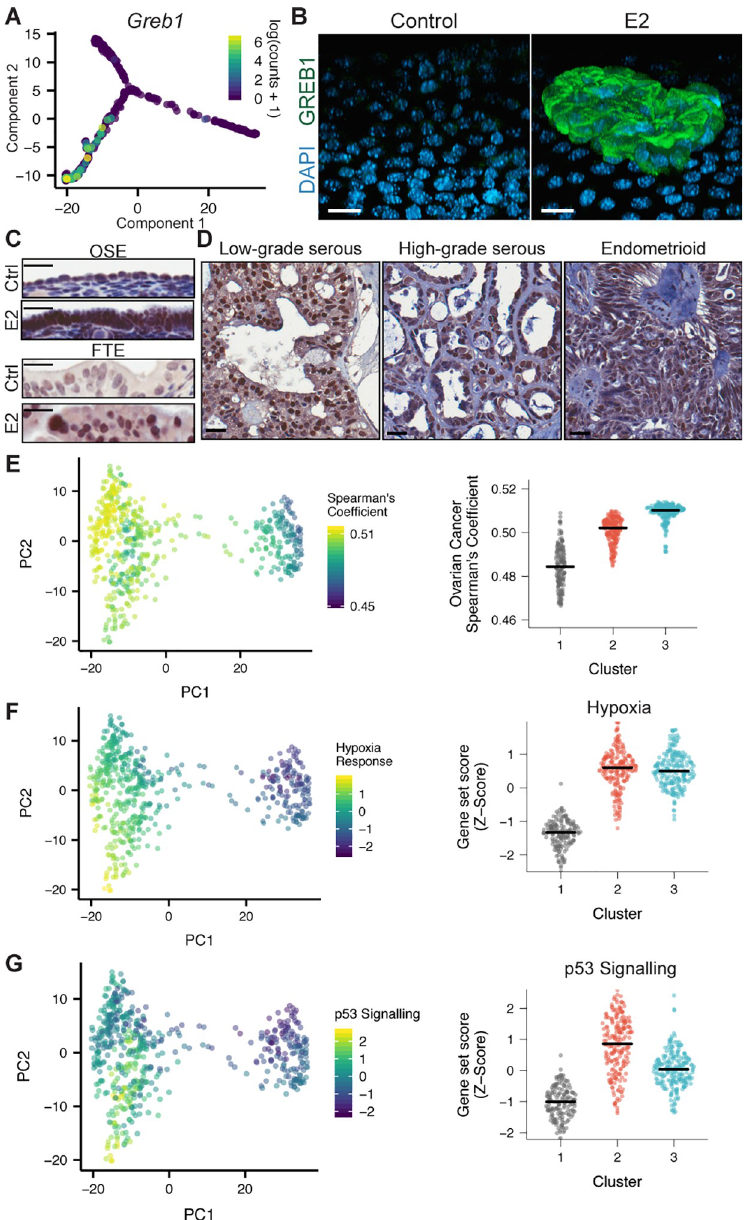
Fig 7. Prolonged E2 exposure leads to up-regulation of GREB1 in stratified OSE cells. (A) Trajectory of OSE cells, coloured by the logged Greb1 counts. (B) Control and E2-treated OSE cells stained for GREB1 by IF. Scale-bar = 15 μ m. Representative images display z-stack maximal intensity projections of GREB1 and DAPI channels rotated 45˚ along Y-axis to best display image in XYZ dimension. n = 6–8. (C) IHC staining of GREB1 in the OSE and FTE from placebo and E2-treated mice (OSE: n = 4; FTE: n = 3) and three subtypes of human ovarian cancer (D): low-grade serous (n = 4), high-grade serous (n = 16), and endometrioid (n = 20). Scale-bar = 25 μ m. (E) Left: PCA plot of scRNA-seq data with each cell coloured by its Spearman’s correlation coefficient with human ovarian cancer cells from a high- grade serous ovarian tumour [22]. Right: The distribution of correlation values across the three clusters. Horizontal bars represent the median value for each cluster. (F,G) Left: PCA plot of scRNA-seq data with each cell coloured by “Hypoxia” (F) and “p53 Signalling” (G) gene set scores. Right: The distribution of gene set scores across the three clusters. Horizontal bars represent the median value for each